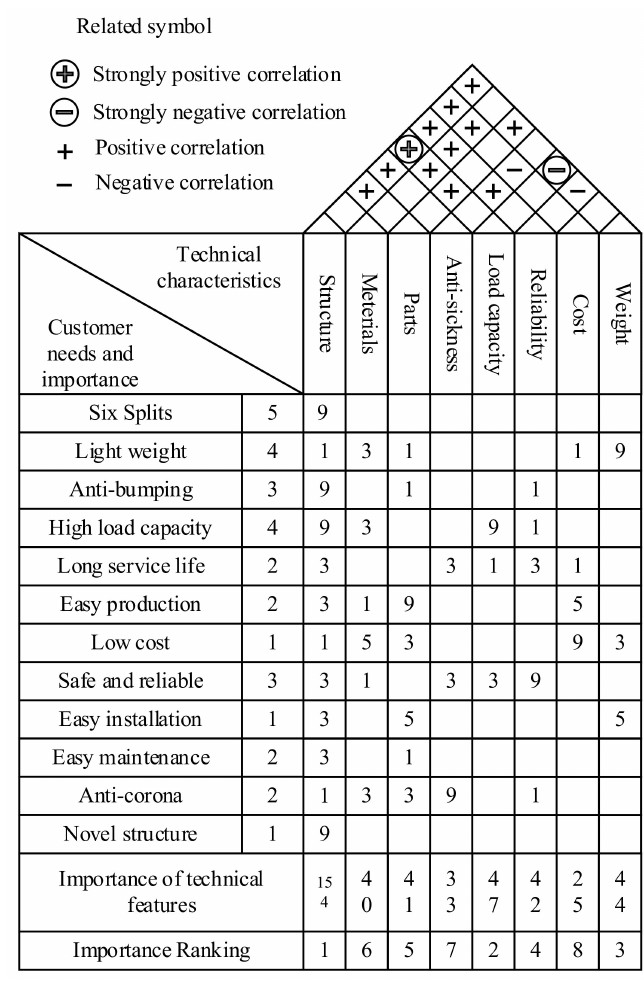
Figure 6. Split drape coupling plate design quality house